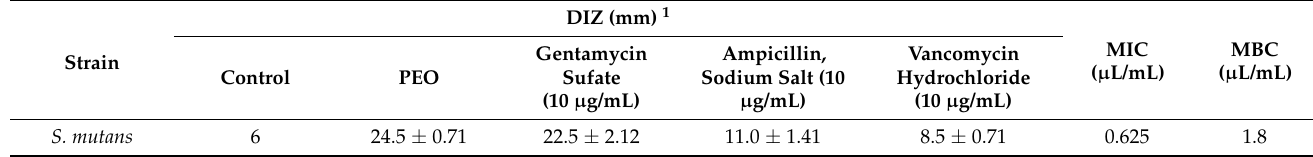
Figure 1 plots the growth curve of S. mutans with or without PEO treatment. The growth of S. mutans nearly stops after treatment with the MIC and 2 MIC levels. Fur- thermore, PEO at 1/2 MIC inhibits the growth rate of S. mutans after treatment for 4 h compared to the control group, and its final OD 600 value was 0.39. This was about half of the control